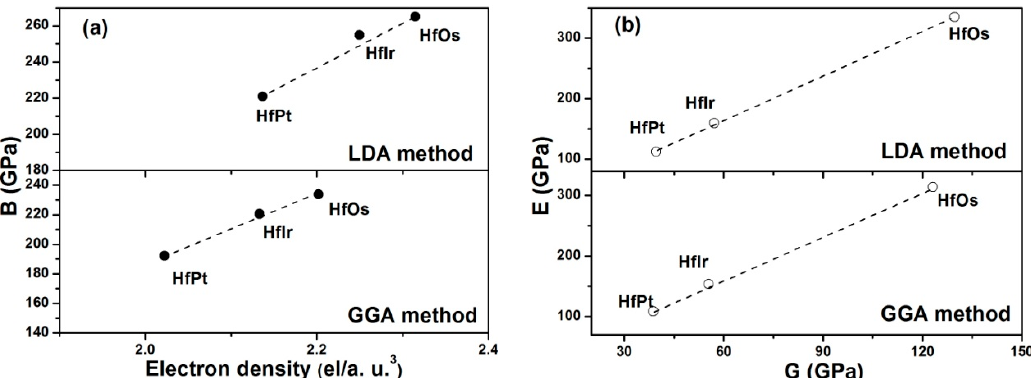
Figure 3. ( a ) Correlations between bulk modulus and electron density; ( b ) Correlations between shear modulus and Young’s modulus for HfX (X = Os, Ir and Pt).